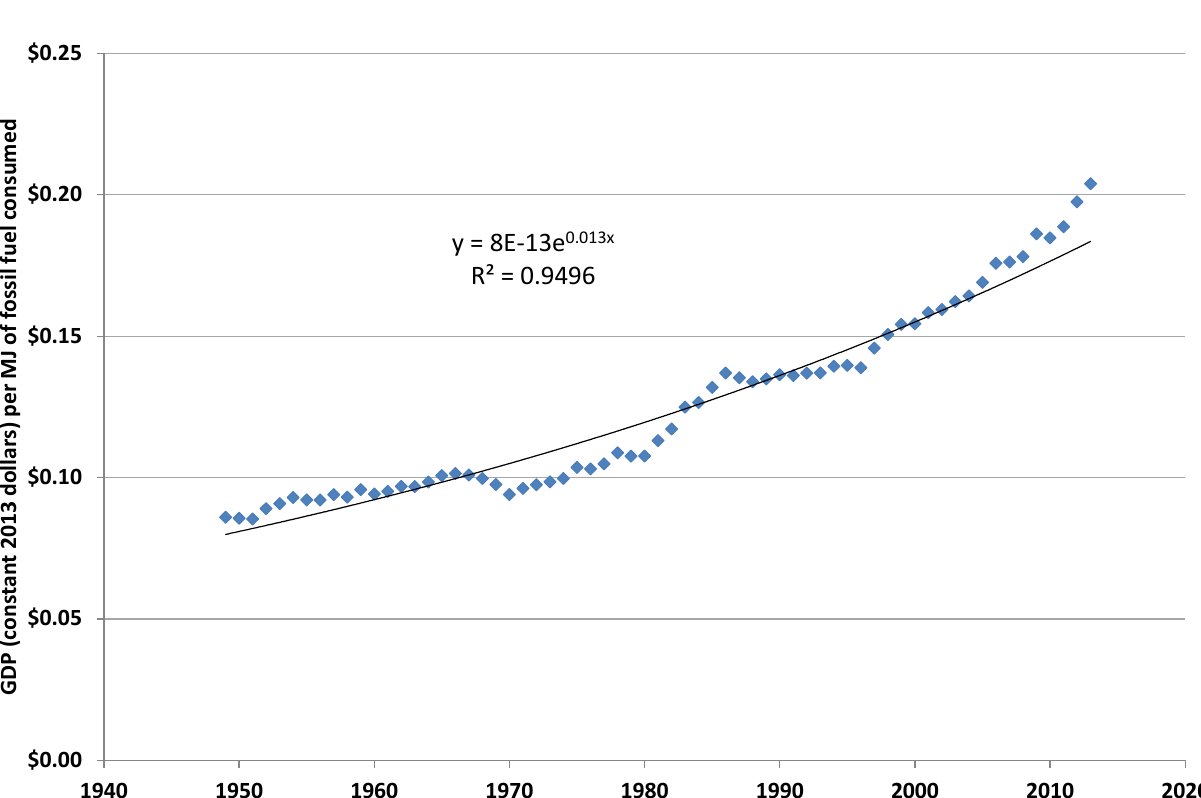
y = 8E-13e 0.013x R² =